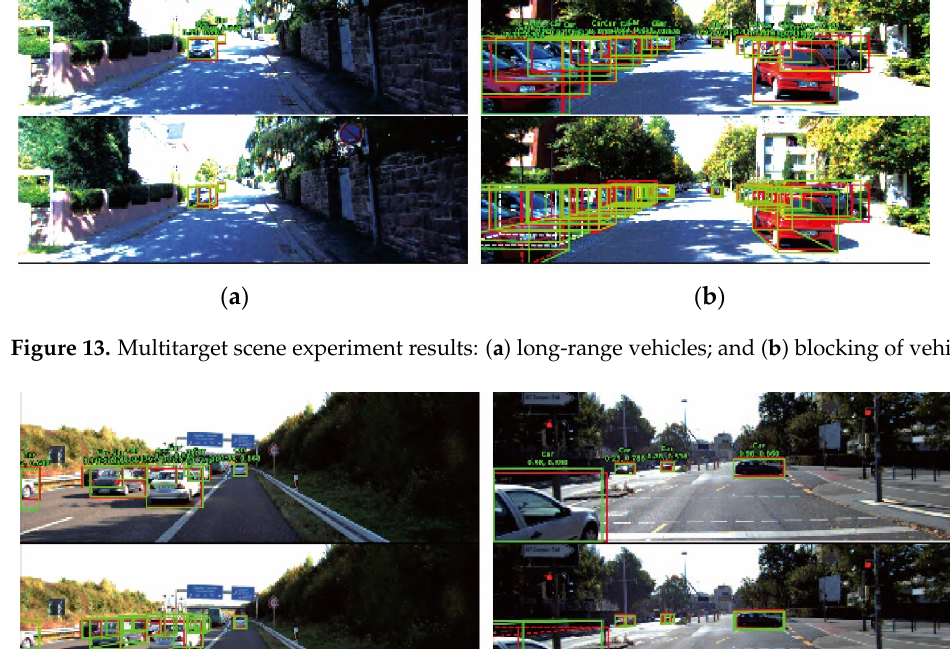
Figure 12. Illumination scene experiment results: ( a ) shade shading; and ( b ) light blocking.